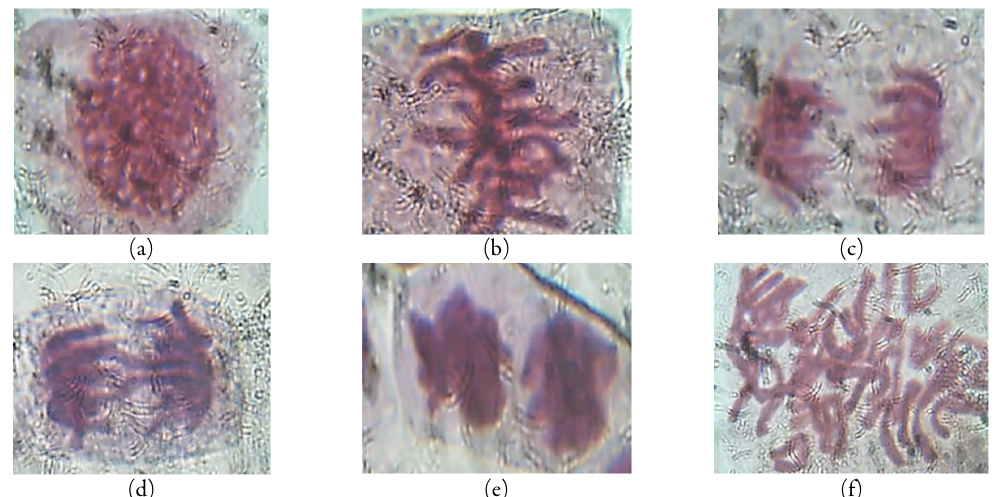
Figure 3. Photomicrographs of some representative normal and aberrant dividing cells a = normal prophase; b = normal metaphase; c = normal anaphase; d = bridged chromosomes; e = sticky chromosomes; f = vagrant